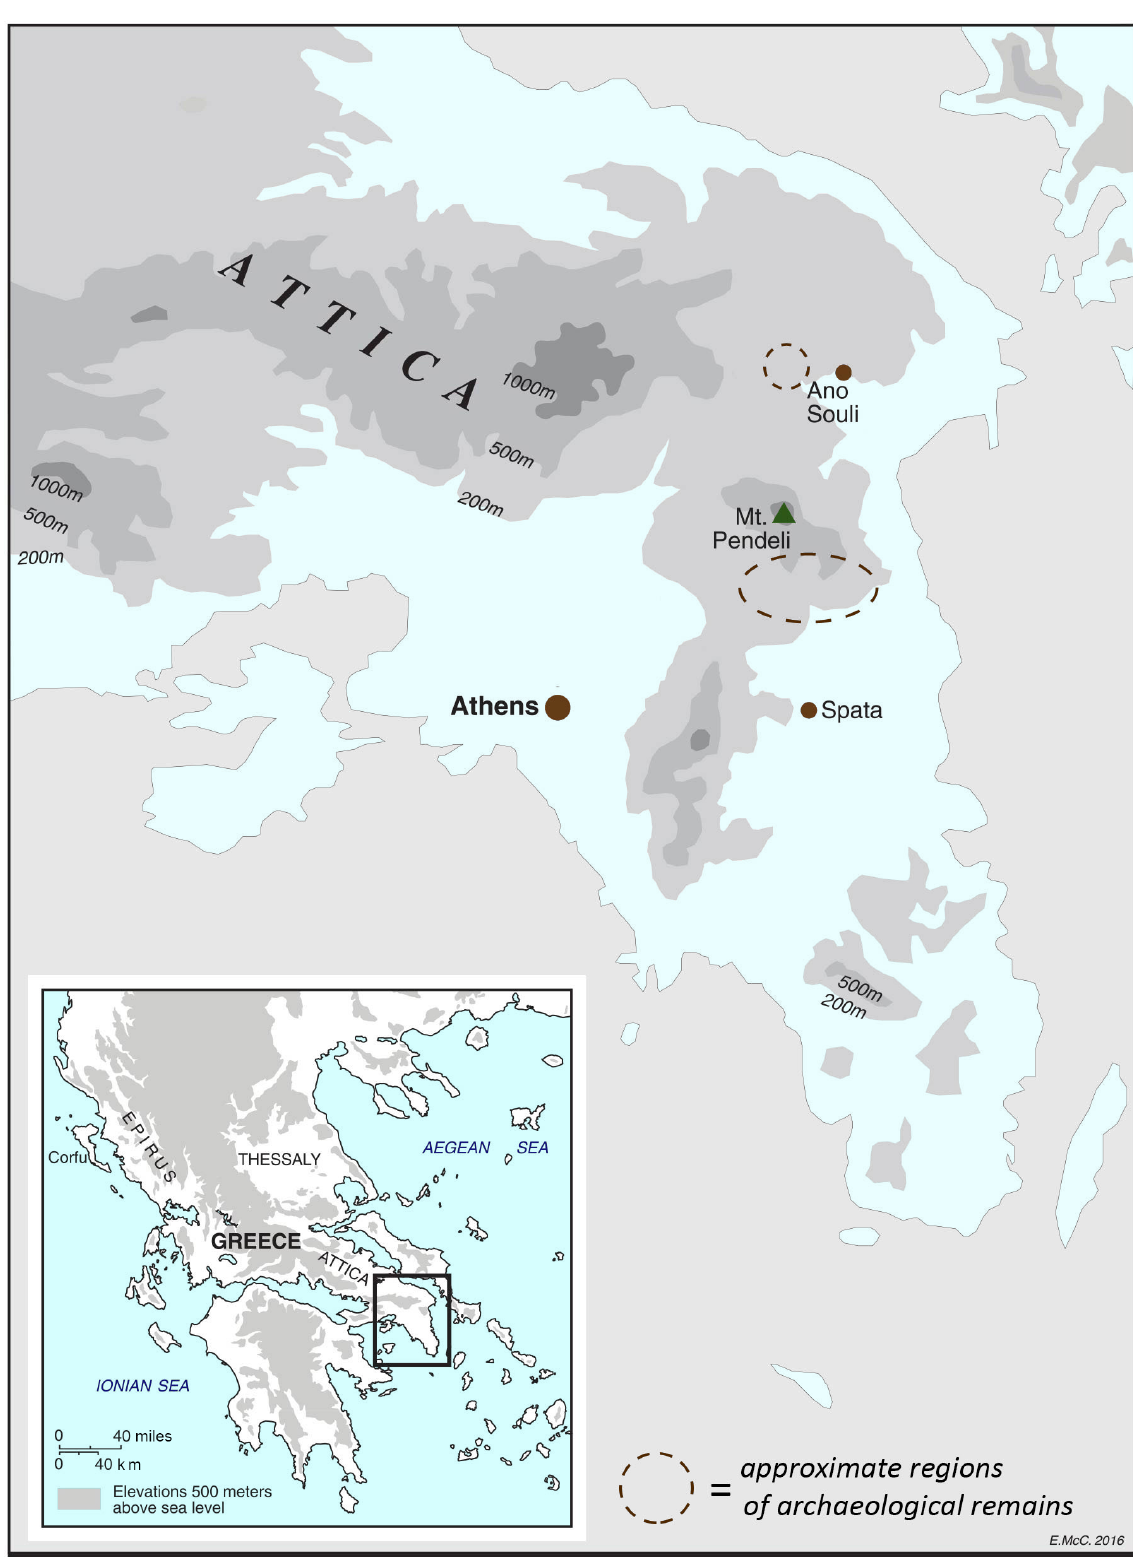
Figure 1. Approximate area where the collection of Palaeolithic stone artefacts was made. Map by Eliza